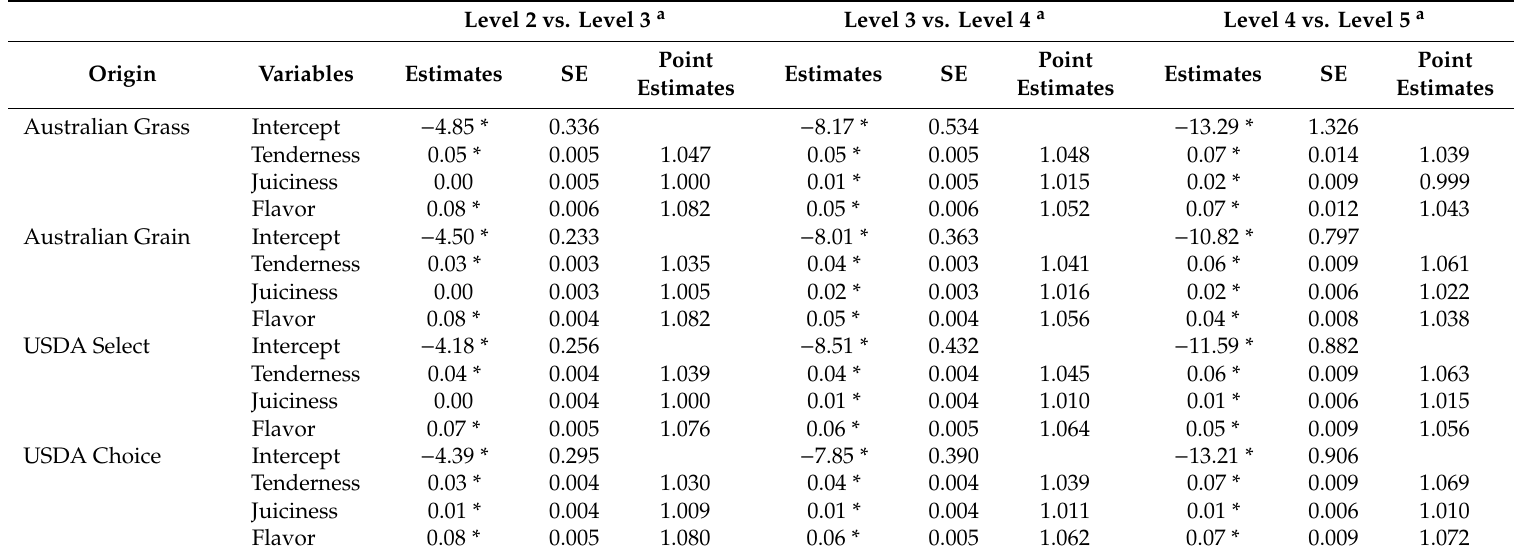
Table 15. Conditional logit model focusing on